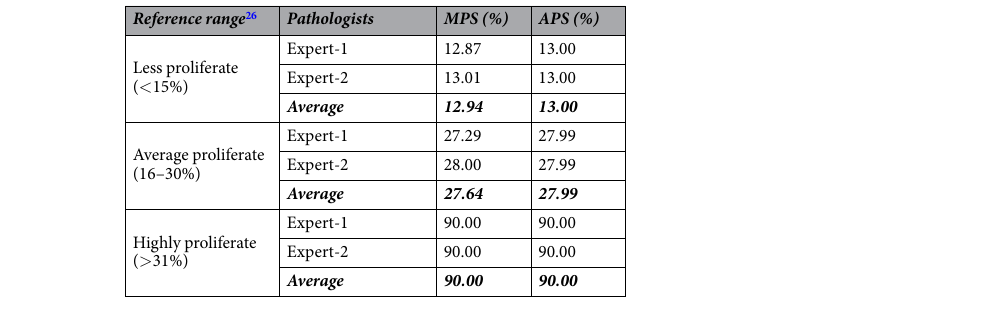
Table 6. Overall proliferation score. ‘MPS’: Manual Proliferation Score